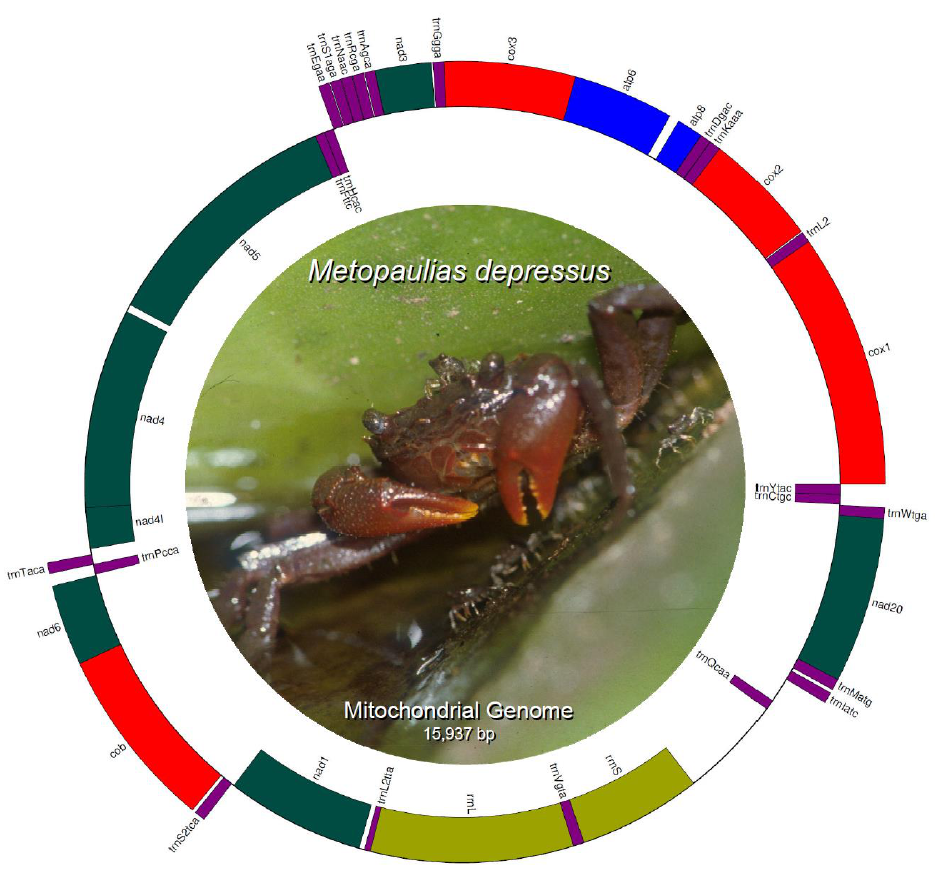
Figure 1. Circular genome map of Metopaulias depressus mitochondrial DNA. Photo credit: Rudolph Diesel.